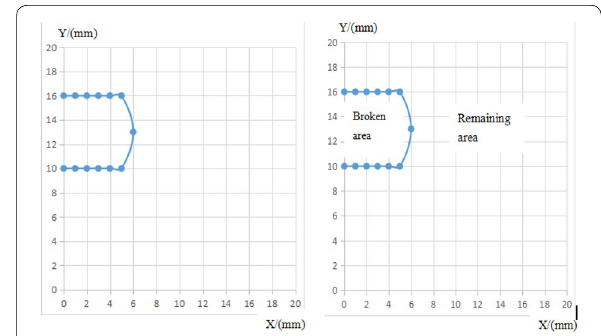
Figure 7 Meshing and damage location meshing and identification